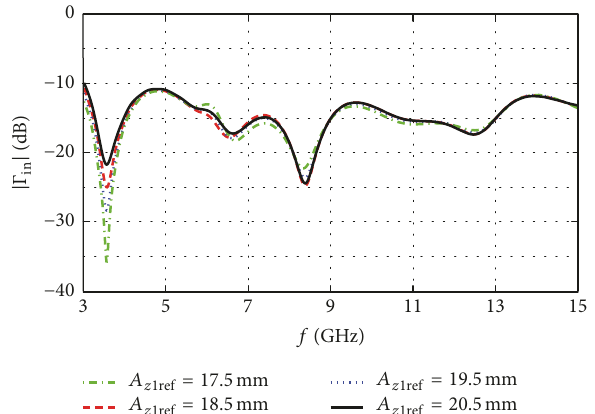
Figure 6: Magnitude of the input reflection coefficient versus frequency for the drop-shaped dipole antenna equipped with a metalreflectorcomputedfordifferentvaluesoftheparameter 𝐴 𝑧1 ref . Structure characteristics: 𝑤 𝑡 = 0.7 mm, 𝑙 𝑡 = 30 mm, 𝐷 = 20 mm, 𝐴 = 20 mm, 𝐴 = 11.6 mm, and 𝐴 = 4.65 mm. 𝑥1 ref 𝑥2 ref 𝑧2 ref Figure 8: Magnitude of the input reflection coefficient versus frequency for the drop-shaped dipole antenna equipped with and without metal reflector. A good agreement between the FDTD numerical result and the experimental measurement is